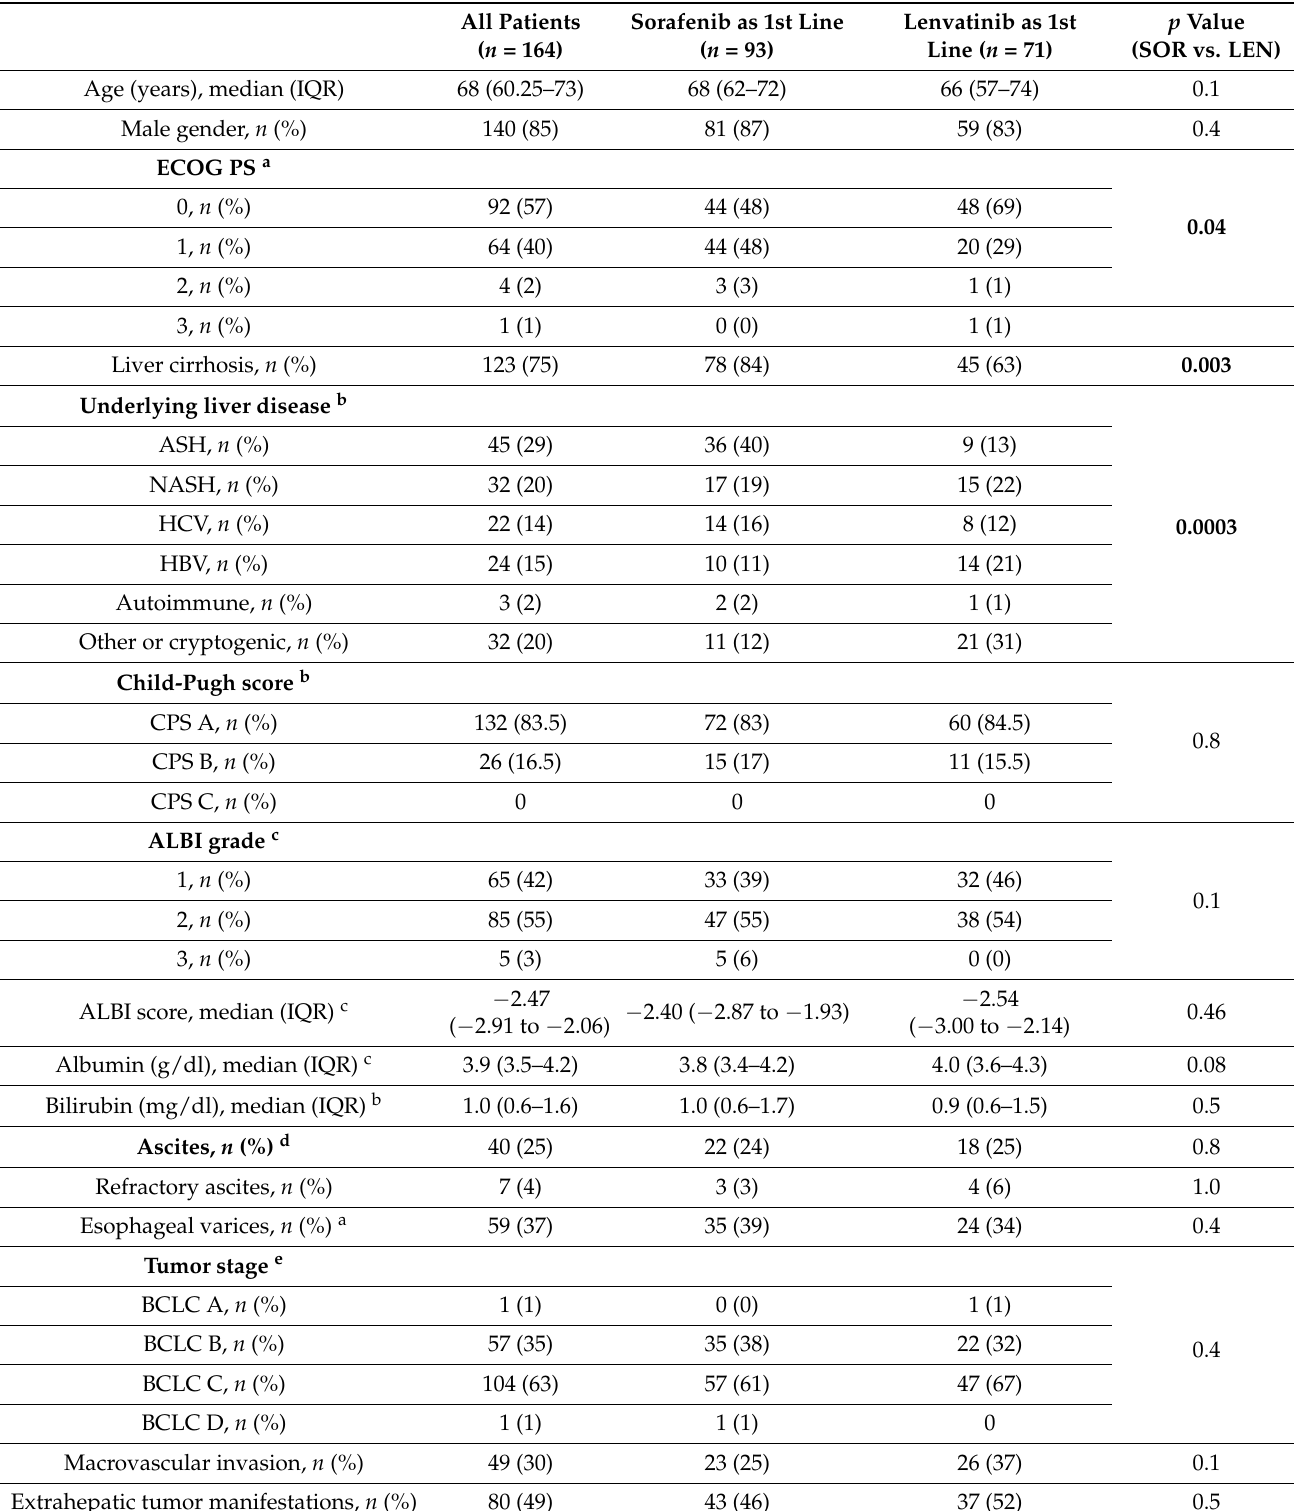
Table 1. Baseline characteristics of all included